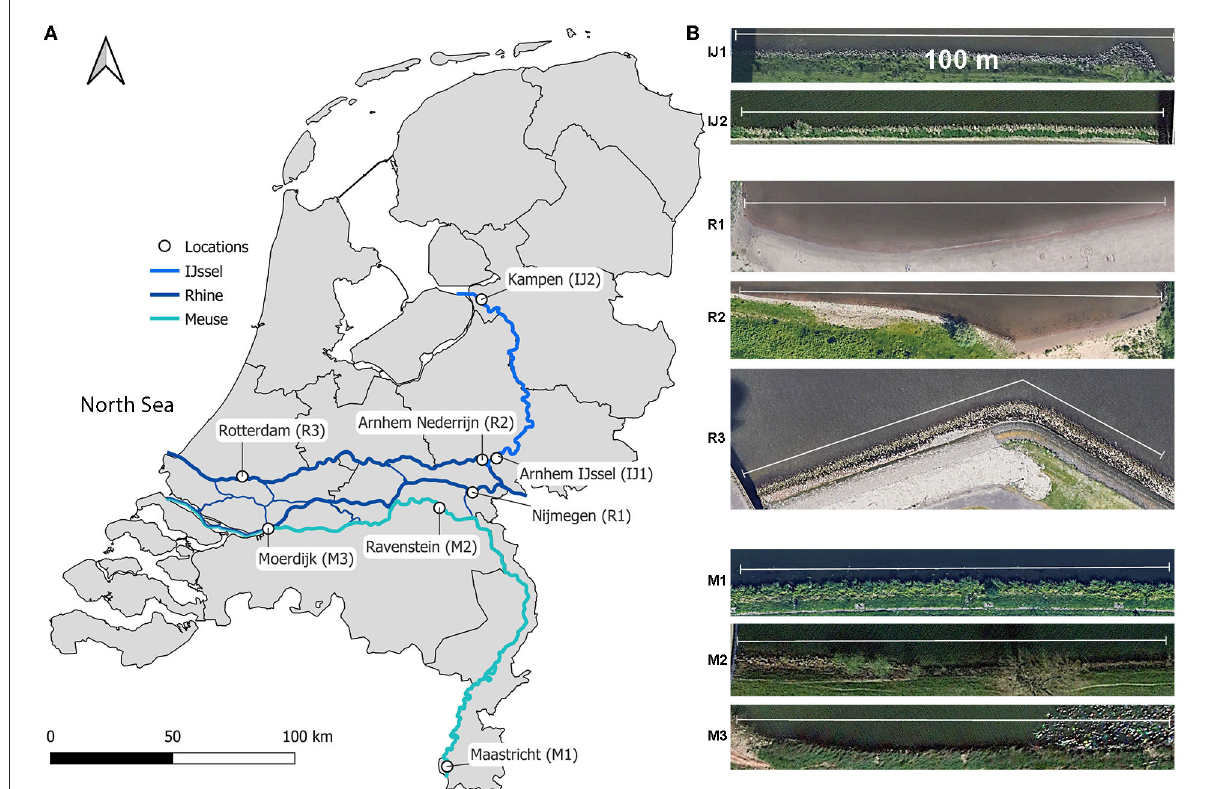
FIGURE1 The study area (A) with the sample areas (Google Earth; Landsat and Copernicus). (B) The white line has a length of 100m. Supplementary material B provides more detailed information on the riverbanks. Sampling locations are chosen at the upstream and downstream end of the Dutch part of the river Rhine (R), Meuse (M), and IJssel (IJ). The river Meuse has an additional midpoint measurement, and the river Rhine has an additional sampling area beyond the first major bifurcation. The sampling areas at Nijmegen (R1; sandy; 130km from the mouth), Arnhem (R2; sandy; 130km from the mouth), and Rotterdam (R3; stones; 30km from the mouth) characterize the river Rhine, Arnhem (IJ1; sandy; 125km from the mouth) and Kampen (IJ2; vegetated; 16km from the mouth) characterize the river IJssel, and the river Meuse was sampled at a location in Maastricht (M1; vegetated; 250km from the mouth), Ravenstein (M2; vegetated; 138km from the mouth), and Moerdijk (M3; vegetated; 56km from the